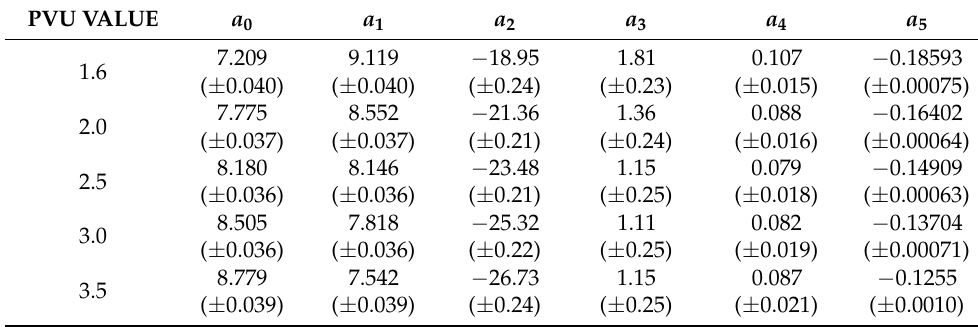
Table 2. Coefficients ( a 0 − 5 ) estimated for Southern Hemisphere, see Equation (4).